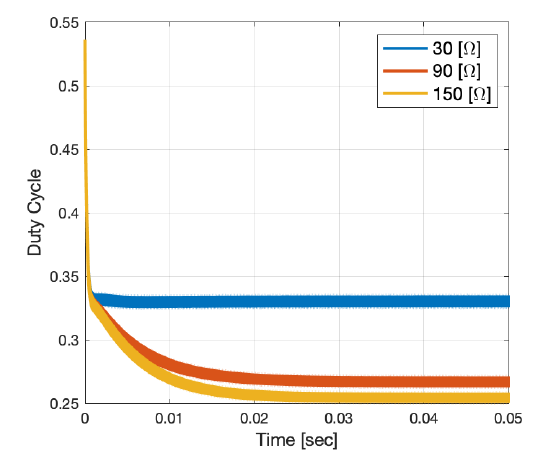
Figure 20. Control signals in the optimized